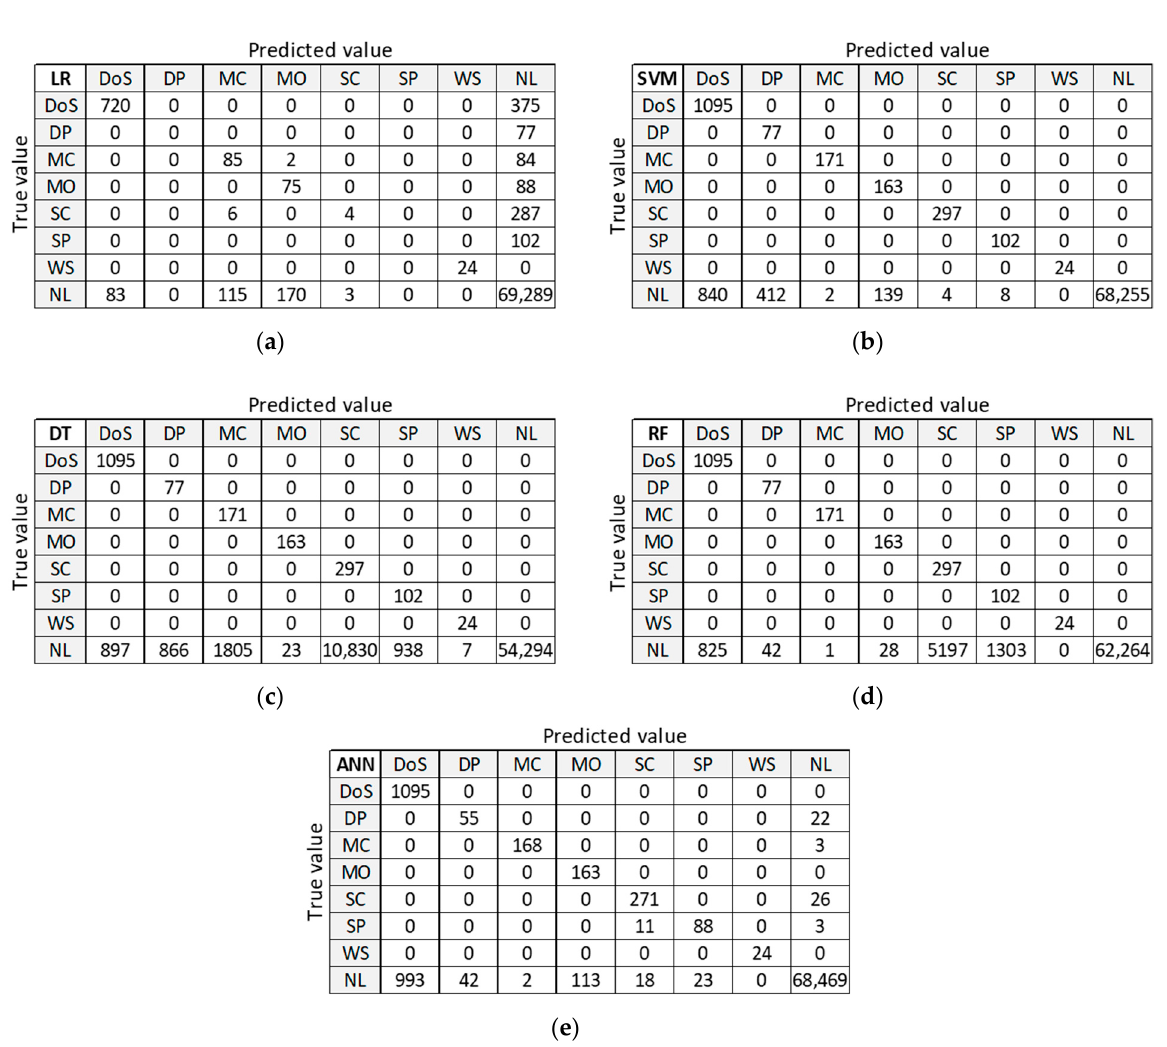
Figure 13. Accuracy measure for ML algorithms on balanced training datasets DCi : ( a ) training accuracy (coincidence of RF and DT); ( b ) test accuracy.